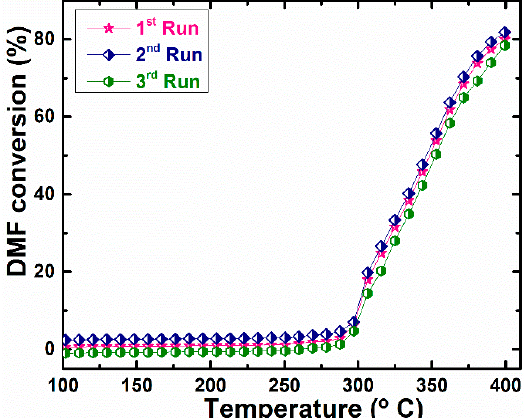
Figure 8. Reproducibility of DMF conversion over CeO x catalyst.